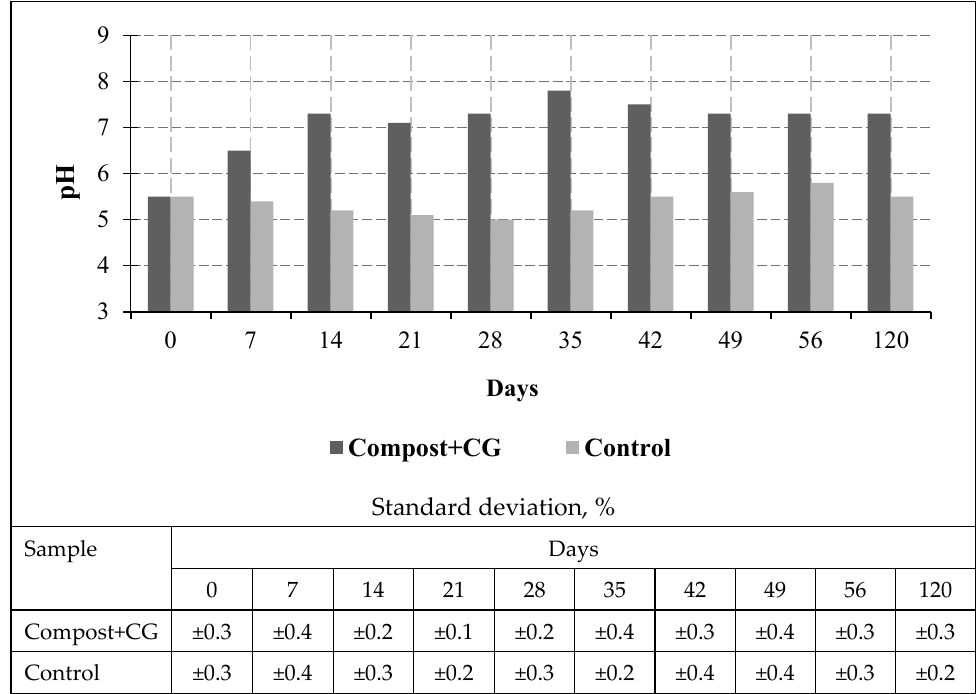
Figure 6. pH change during composting.